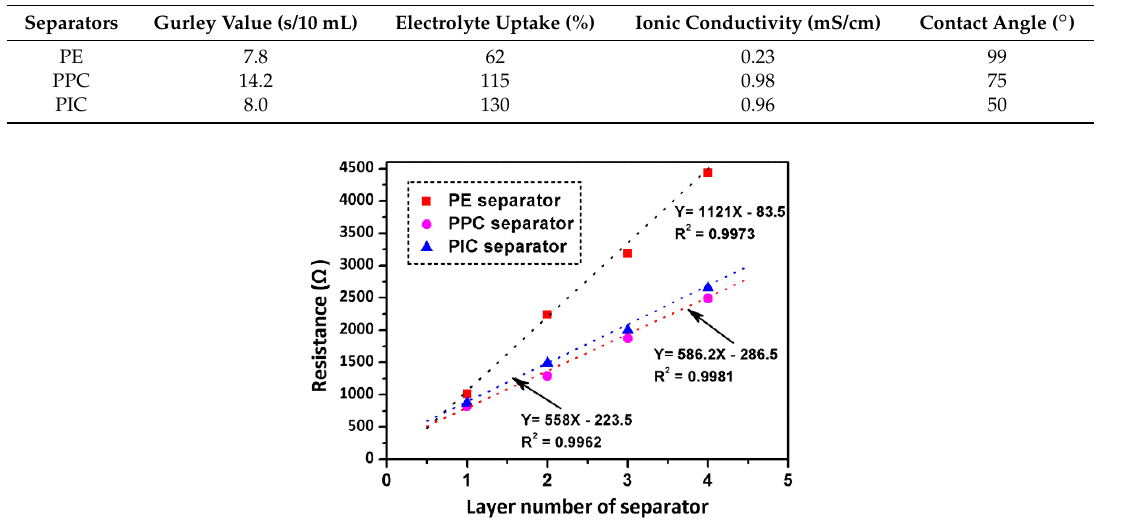
Figure 4. The relationship of separator resistance and layer number of separator for PE separator, PPC separator, and PIC separator. The linear fitting results are shown in dotted line.